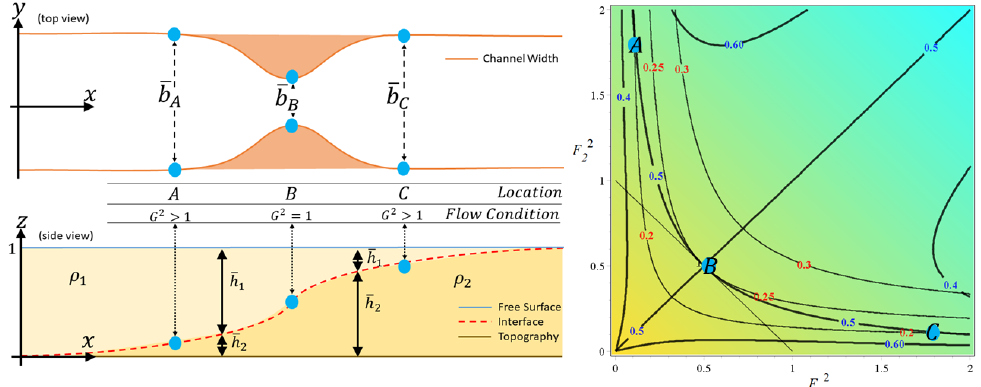
Figure 10. ( Left ) Top and side views of the steady interface of the maximal exchange flow due to contraction (not to scale). ( Right ) The Froude number planes with several contours of the rigid-lid and Bernoulli are plotted in red and blue labels, respectively, whereas the straight line represents the criticality condition (9). The Bernoulli contour, shown as a solid curve A − B − C , depicts the steady interface of the maximal exchange